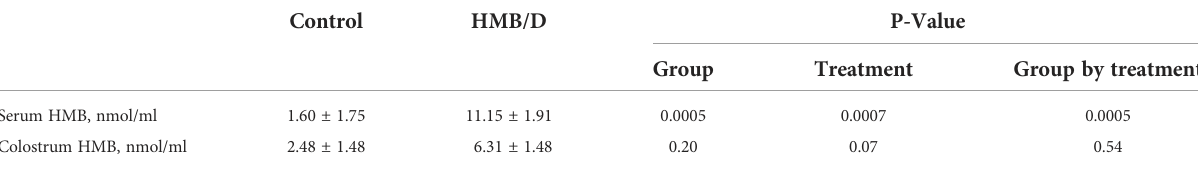
TABLE 7 The effect of supplementing calcium beta-hydroxy-beta-methylbutyrate and vitamin D (HMB/D) during late gestation and lactation on sow serum and colostrum HMB levels.